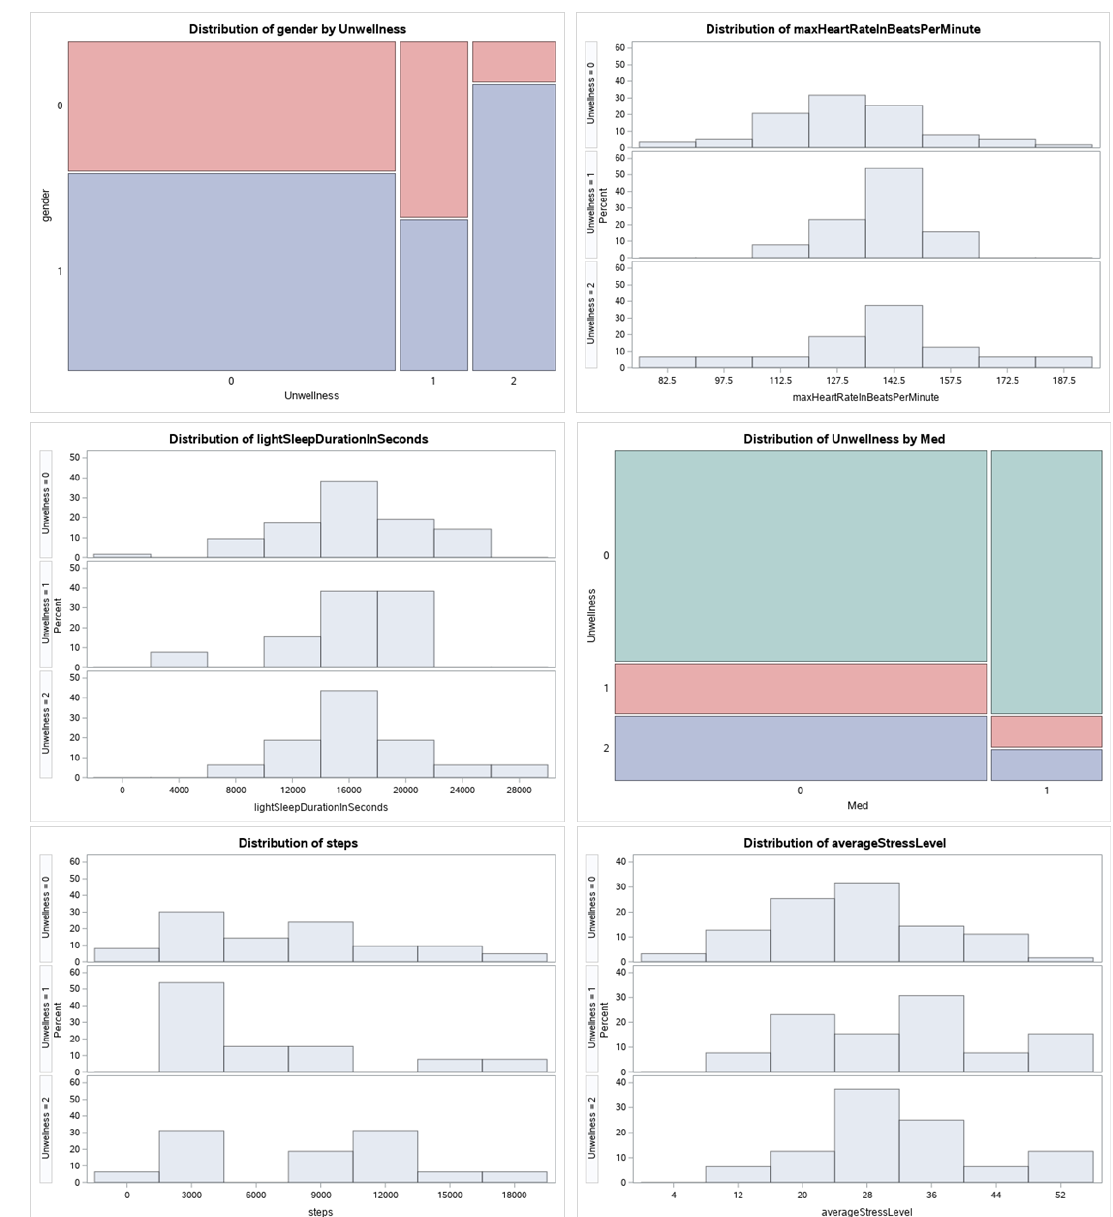
Figure 10. Relationship between